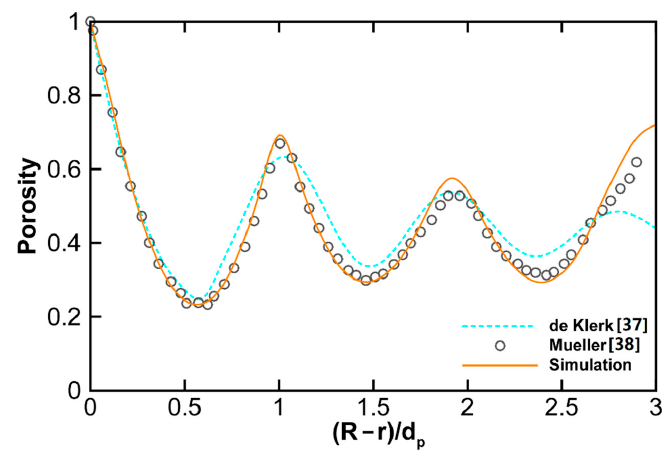
Figure 8. Comparison of radial porosity distribution profile for the current packing model with a correction from de Klerk [37] and an algorithm from Mueller [38].